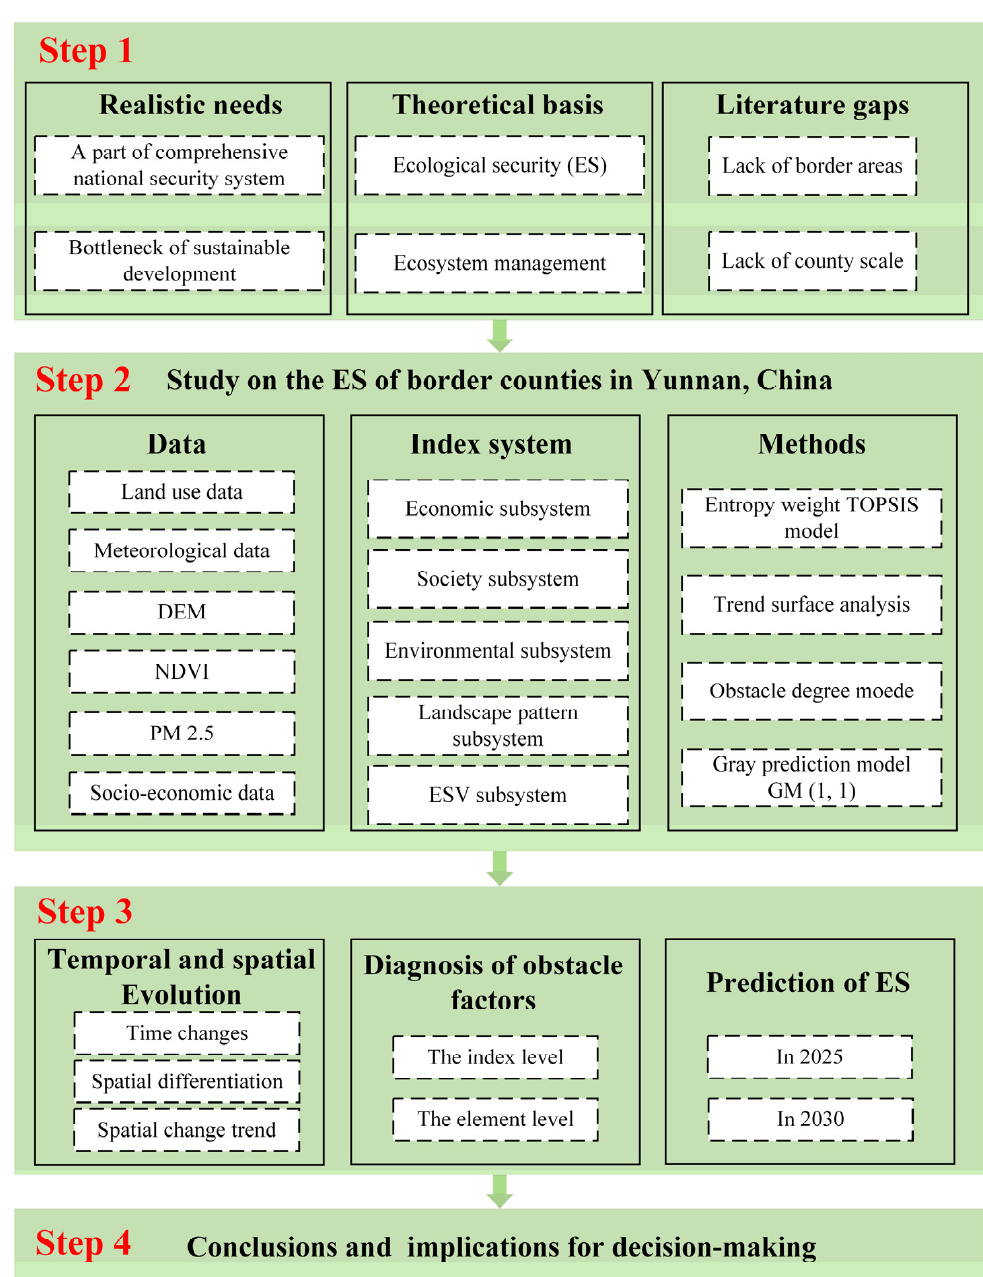
Figure 2. The research framework used in this